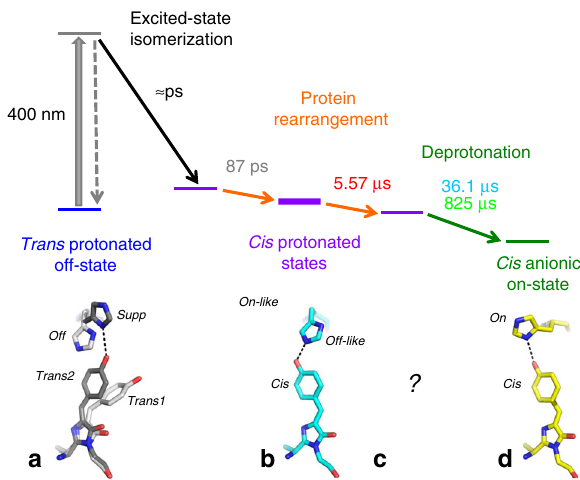
Fig. 7 Model for the rsEGFP2 off-to-on photoswitching process. The bold purple bar represents the laser_on_ Δ 10 ns intermediate structure determined by TR-SFX. Time constants correspond to those determined by femtosecond (87 ps) and nanosecond-resolved pump – probe UV – visible absorption spectroscopy (5.57, 36.1 and 825 µ s) in H 2 O solution (50 mM HEPES pH 8, 50 mM NaCl). All three cis protonated states (purple bars) are ground-state intermediates, interconversion of which involves rearrangements of the protein matrix (orange arrows). Corresponding structural models for the chromophore and His149 as determined by X-ray crystallography are shown in panels a , b (this work) and d 27 . Trans1 and His149-off (light gray) and trans2 and His149-supp (dark gray) of the trans- protonated off-state (a, Fig. 3c) transited to cis and His149-off-like at 10 ns ( b , Fig. 4b, Fig. 6b, e). His149-off-like has moved to His149-on in the cis anionic on state ( d , Fig. 6c, f). The structure whose intermediate forms in 5.57 µ s remains elusive ( c